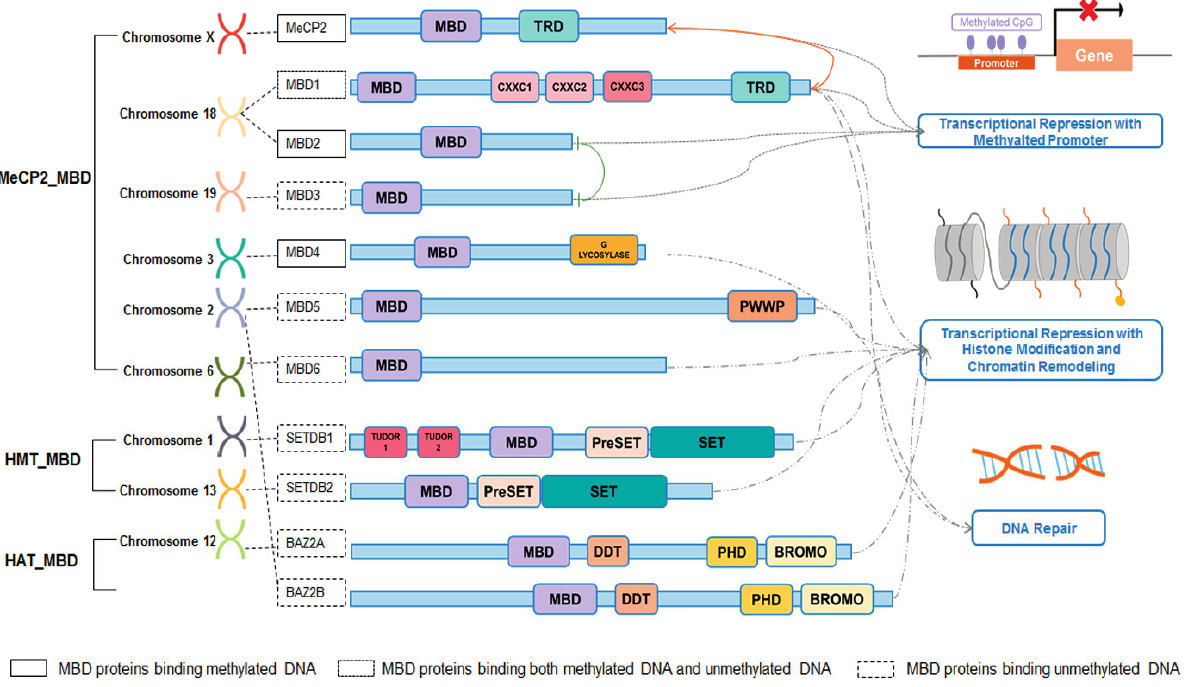
Figure 1. Locations, structures and functions of the methyl-CpG-binding domain MBD